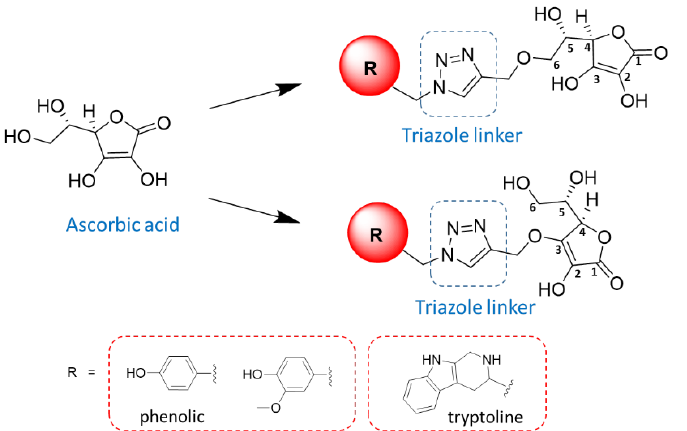
Figure 1. Chemical structure of ascorbic acid and its conjugation via triazole linker with tryptoline and phenolic moieties to create novel compounds with multitargeted functionality to treat Alzheimer’s disease.